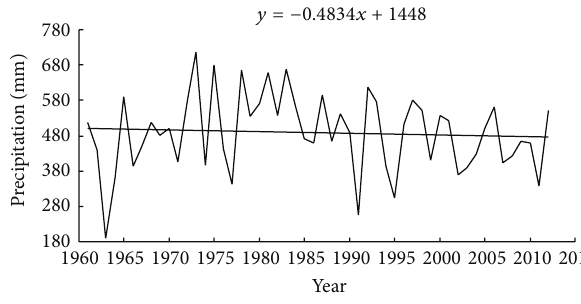
Figure 5: The overall variability and changes of spring precipitation in South